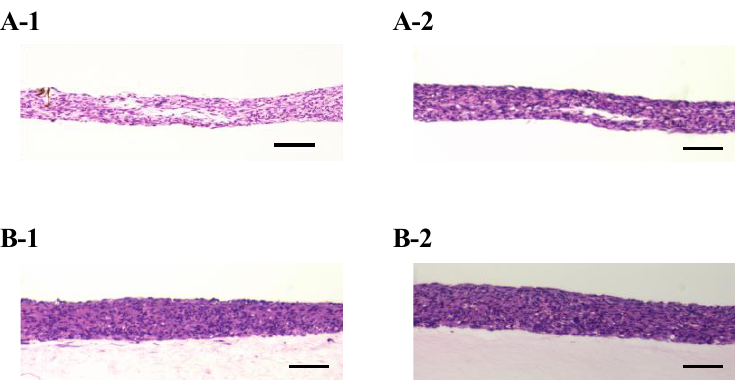
HE cross-sectional images of the other samples (Figure A2) and a schematic showing Table A2. The content of the collagen solution introduced in the step shown in Figure A1E. the measurement of mechanical stimulation (Figure A3) are presented in this study.